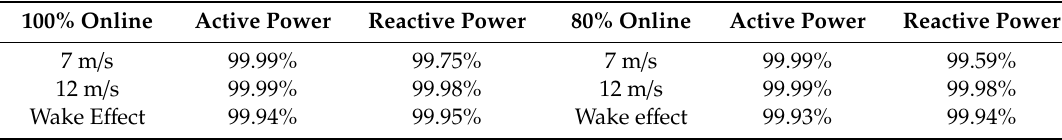
Table 8. Comparisons of fitting curves.